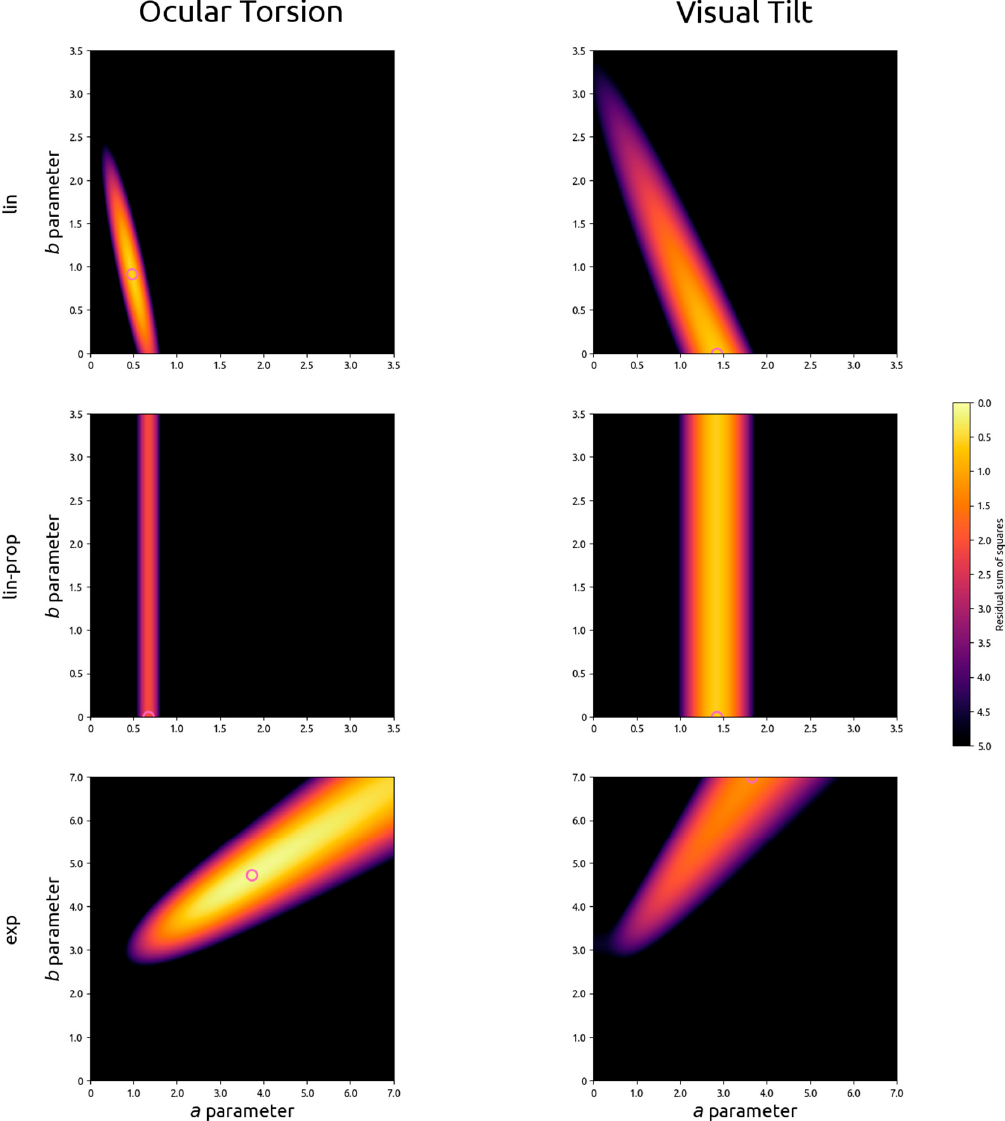
Figure 2. Visualisation of the residual sum of squares in parameter space as a function of the a ( x -axis) and b parameter ( y -axis) in linear models (Equations (1) and (2); top row, titled ‘lin’), directly proportional linear models (Equations (3) and (4); middle row, titled ‘lin-prop’), and exponential models (Equations (5) and (6); bottom row, titled ‘exp’) of the relationship between galvanic vestibular stimulation and ocular torsion ( left column ) or visual tilt ( right column ). Lower values indicate better fits and are indicated by lighter colours. The best fit is indicated by a pink circle.